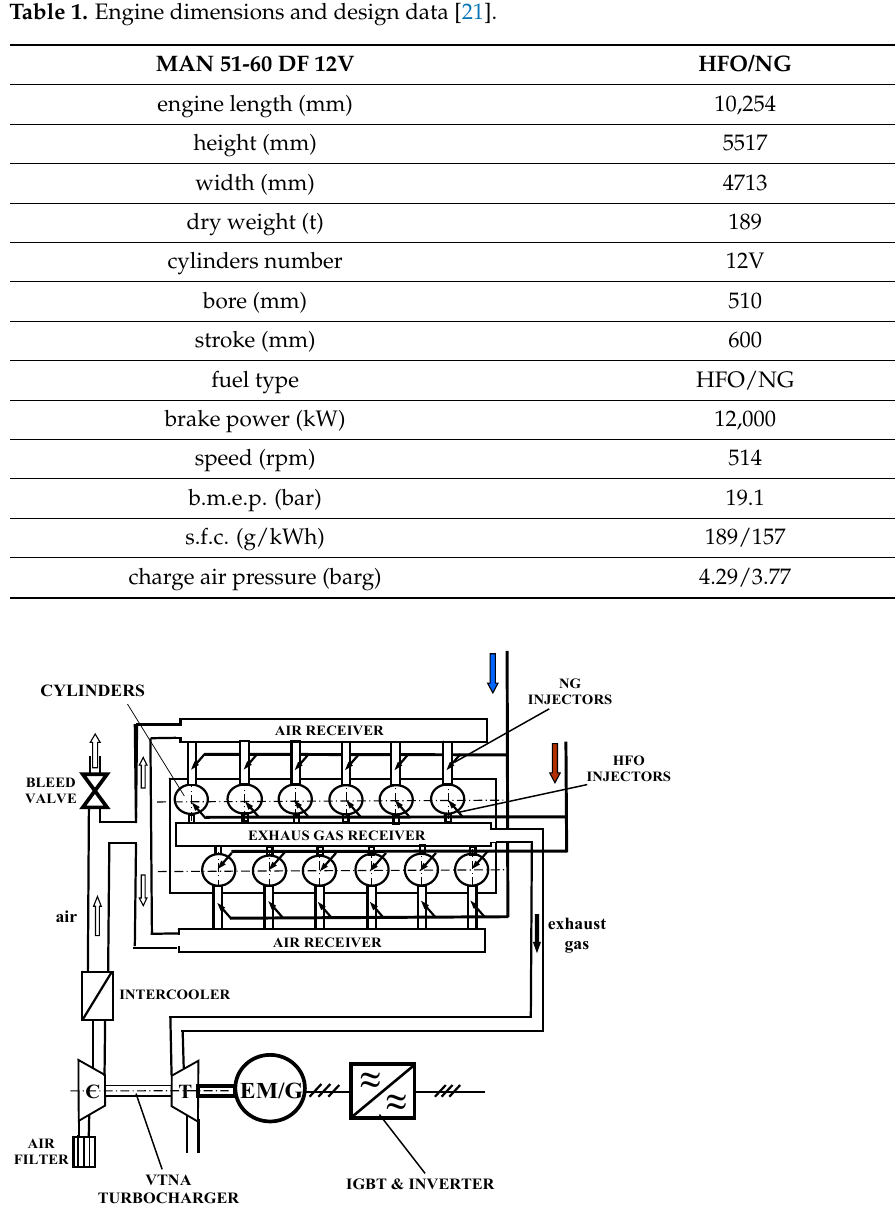
Figure 1. Engine equipment scheme in HTC configuration.